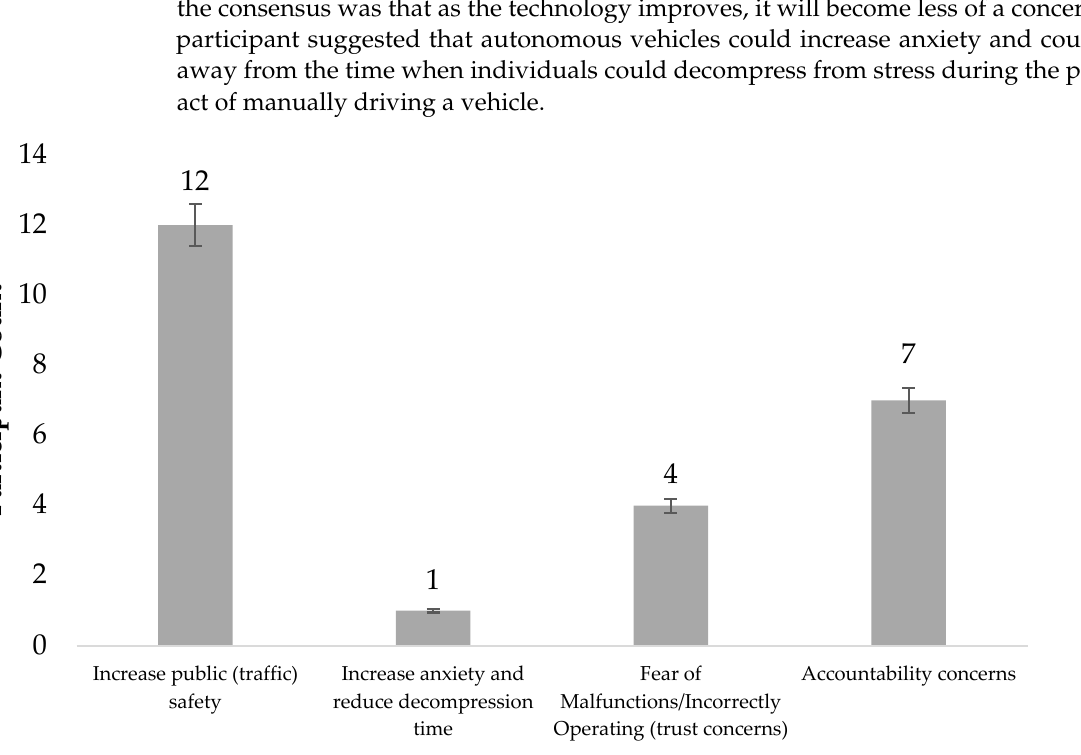
Figure 3. Societal effects of self-driving technology.